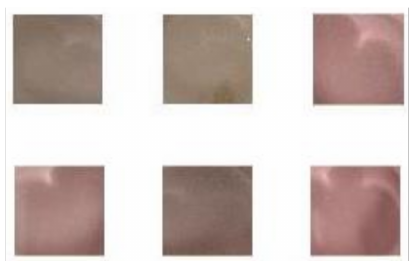
Figure 6. Cropped 500 × 500